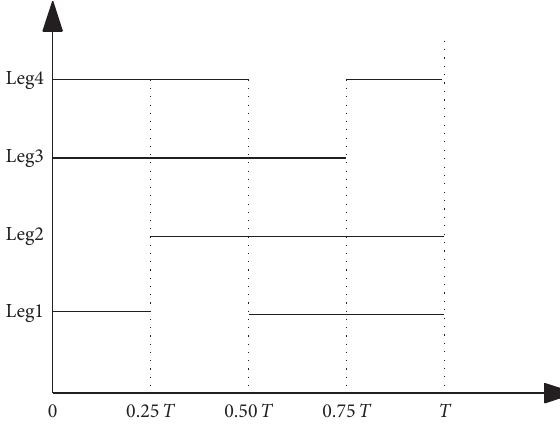
Figure 4: Semi-intermittent continuous gait sequence.